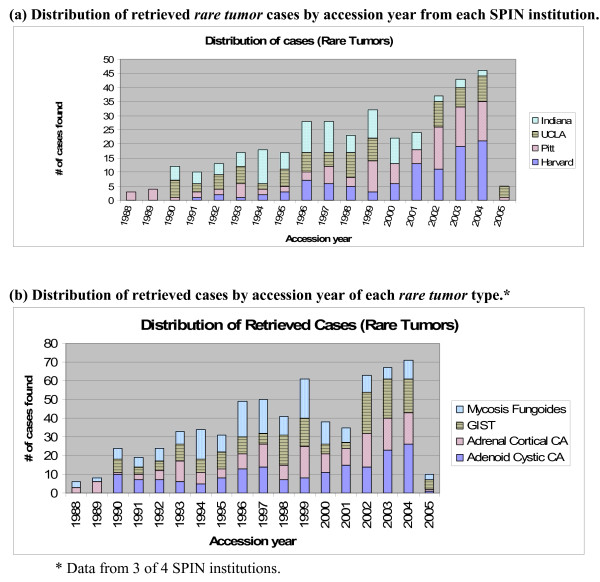
Distribution of retrieved cases for rare tumors. Illustration of number of cases retrieved for rare tumor cases by the original year of accession for that case: (a) Breakdown by each institution and (b) by rare tumor type*. Specimens retrieved and evaluated for the rare tumors encompassed cases accessioned range from 1988–2005 with 62% being greater than 5 years old.